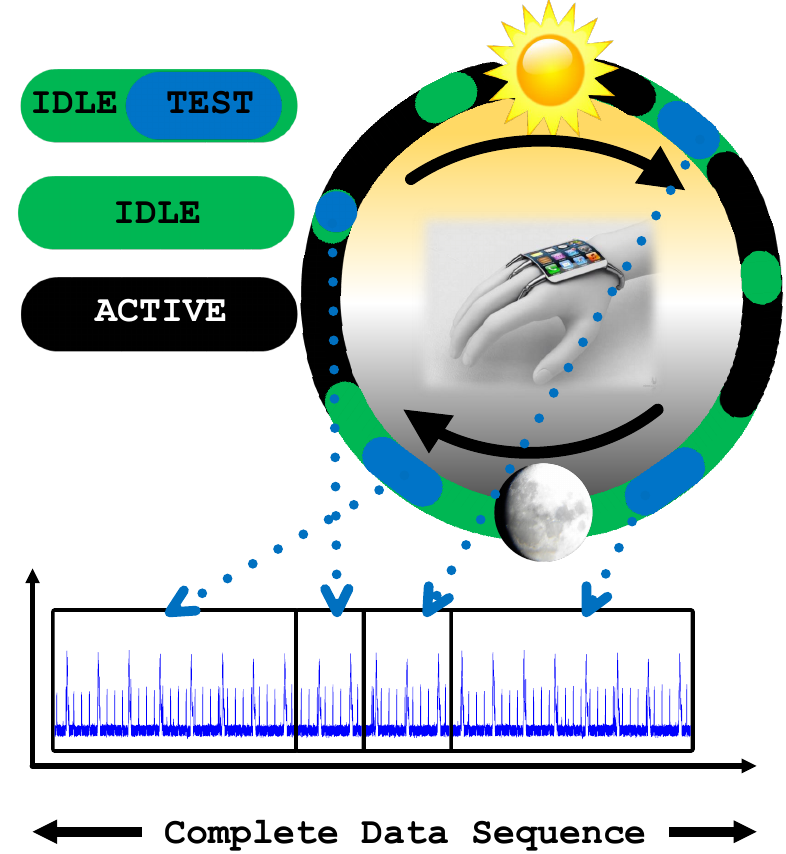
Figure 4. Illustration of device usage in a day and measuring current of device in idle stage for data